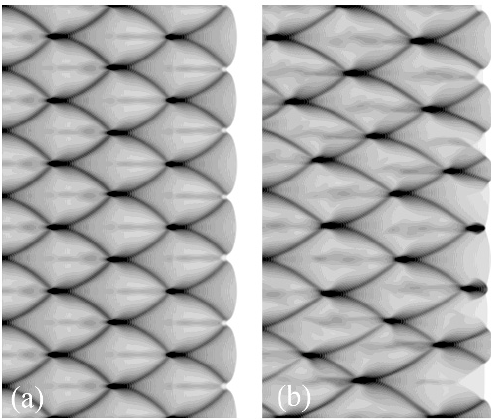
Figure 7. Characteristic geometrical dimensions of a detonation cell for ( a ) ER = 3.0; ( b ) ER = 6.0. The dark area is the trajectory of the triple points. The numerical result is the maximum pressure during detonation propagation.